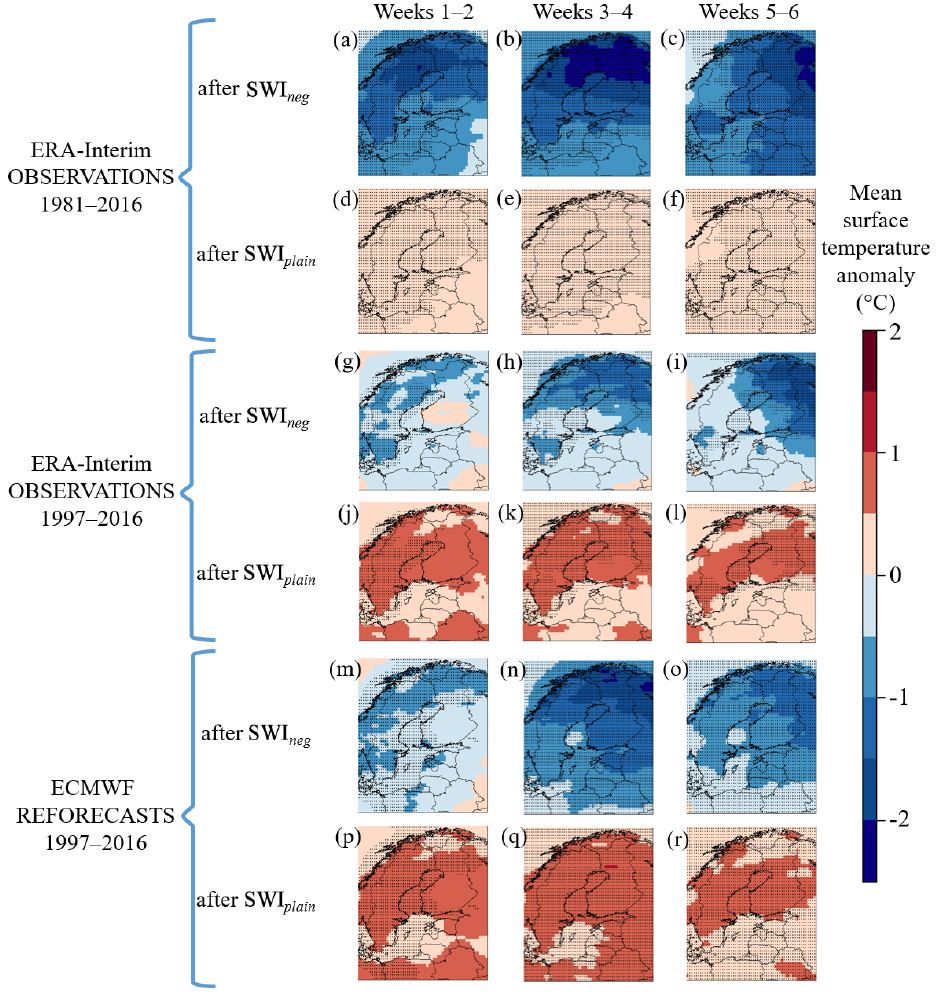
Figure 3. ERA-Interim observed (a–l) and ECMWF reforecasted (m–r) mean temperature anomalies in comparison to the 1981–2016 mean during boreal winters (November–February) in cases where the previous week’s SWI was negative (SWI neg ; covering about 17% of the winter weeks) or plain (SWI plain ; covering about 83% of the winter weeks). The dotted areas represent the 95% level of confidence where the means of surface temperature anomalies, after SWI neg and SWI plain , differ